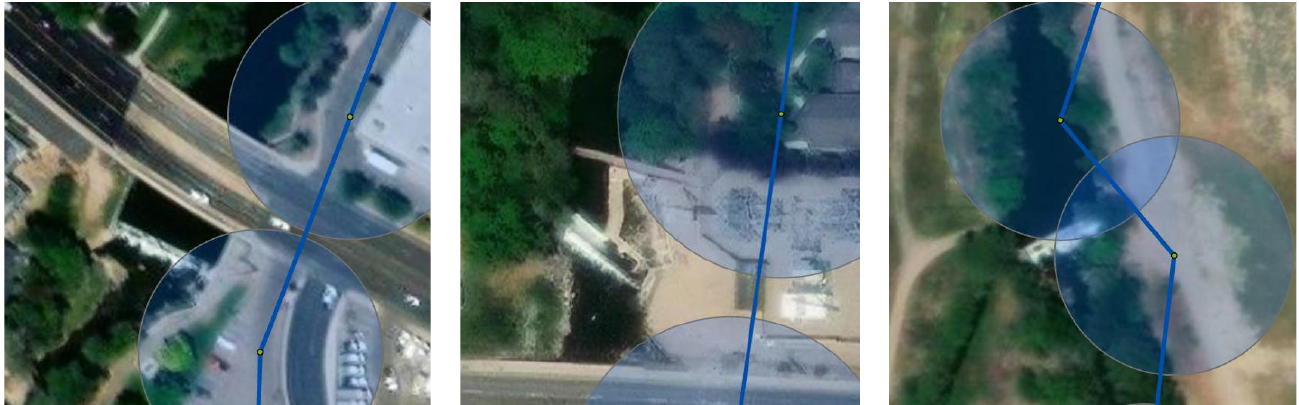
Figure 12. Examples of misplaced Hydrofabric flowlines (Blue lines).